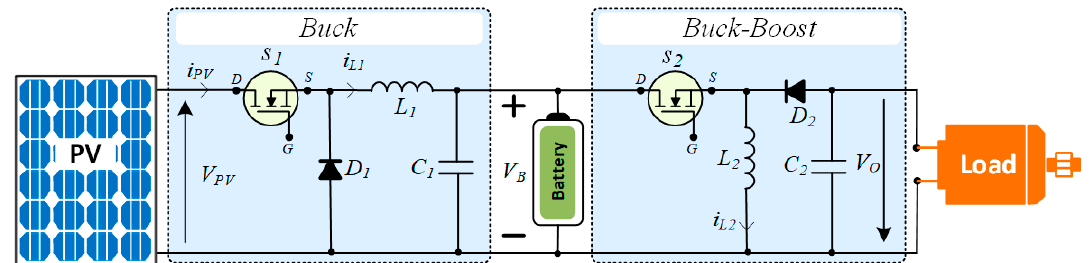
Figure 1. Classical two ‐ stage buck/buck ‐ boost DC ‐ DC circuit based on two switches S 1 and S 2 .